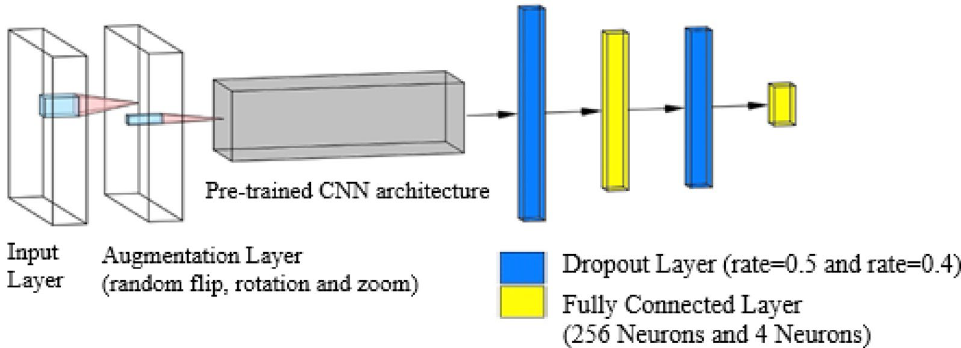
Figure 4. This figure illustrates the standardised pipelines for comparison purposes. The grey box represents one of the seven CNN architectures. Table 6 contains the details of the standardised framework and hyperparameters.